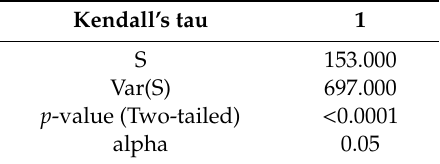
Table 5. Mann–Kendall trend test / two-tailed test (total emissions).